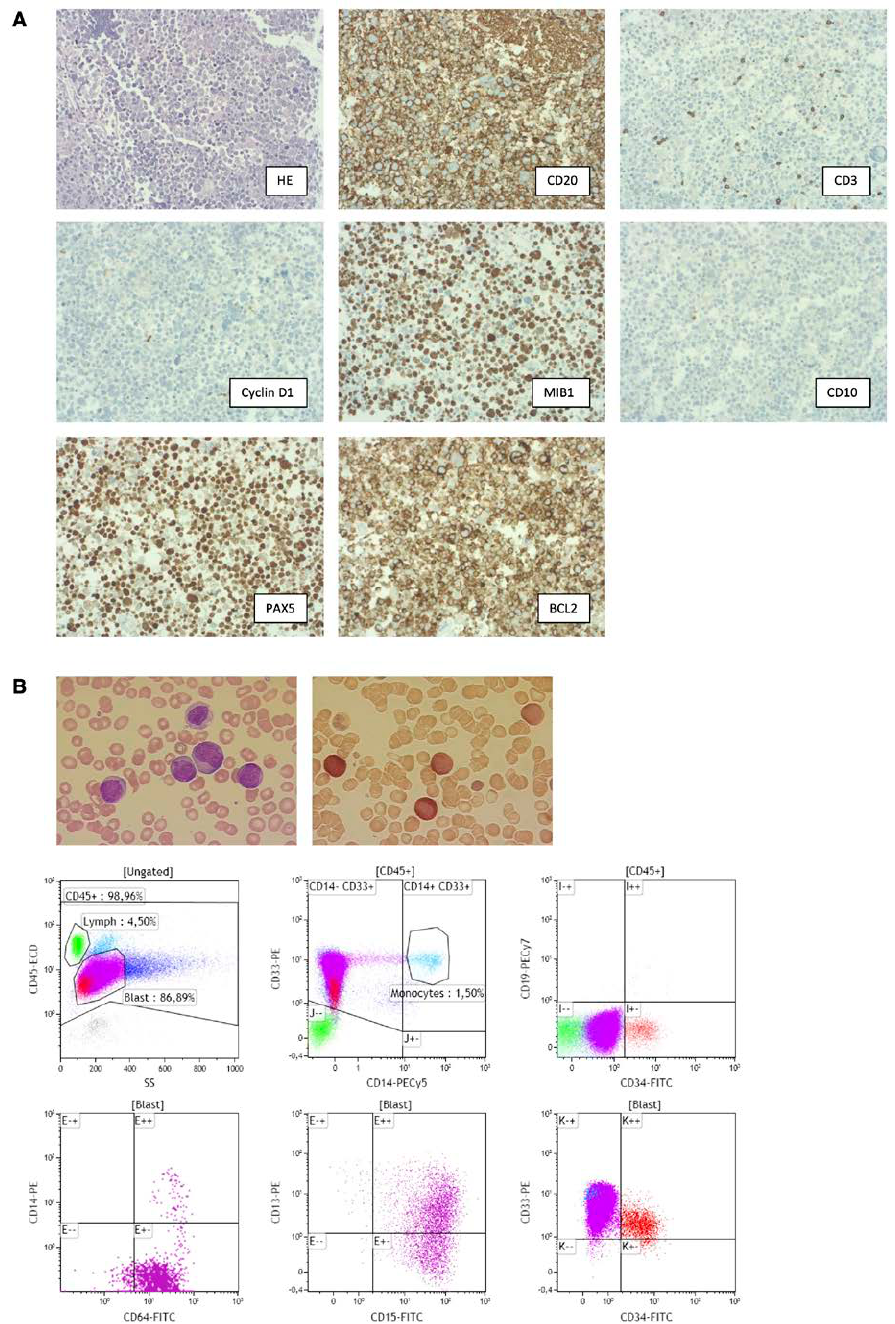
Figure 1. Diagnostic workup of DLBCL and AML of patient. ( A ) Fine needle biopsy of an abdominal lymph node showing an aggressive B-cell-lymphoma expressing CD20, PAX5 and BCL2, without expression of CD3 (some admixed non-neoplastic T-cells are positive), Cyclin D1, and CD10, corre- sponding to a diffuse large B-cell-lymphoma (DLBCL). MIB1 staining indicates expression of Ki-67, a nuclear protein associated with cell proliferation. ( B ) Diagnostic workup from the peripheral blood for AML. Upper panel: cytomorphology. Upper left: Pappenheim stain showing blasts with monocytic morphology and prominent nucleolus. Upper right: esterase staining showing esterase positive blasts. Lower panel: immunophenotyping showing AML blasts with positive expression of CD33+ CD64+ CD13+ and CD15+ and a subpopulation with CD34+, indicative of myelomonocytic leukemia. No expression of B cell marker